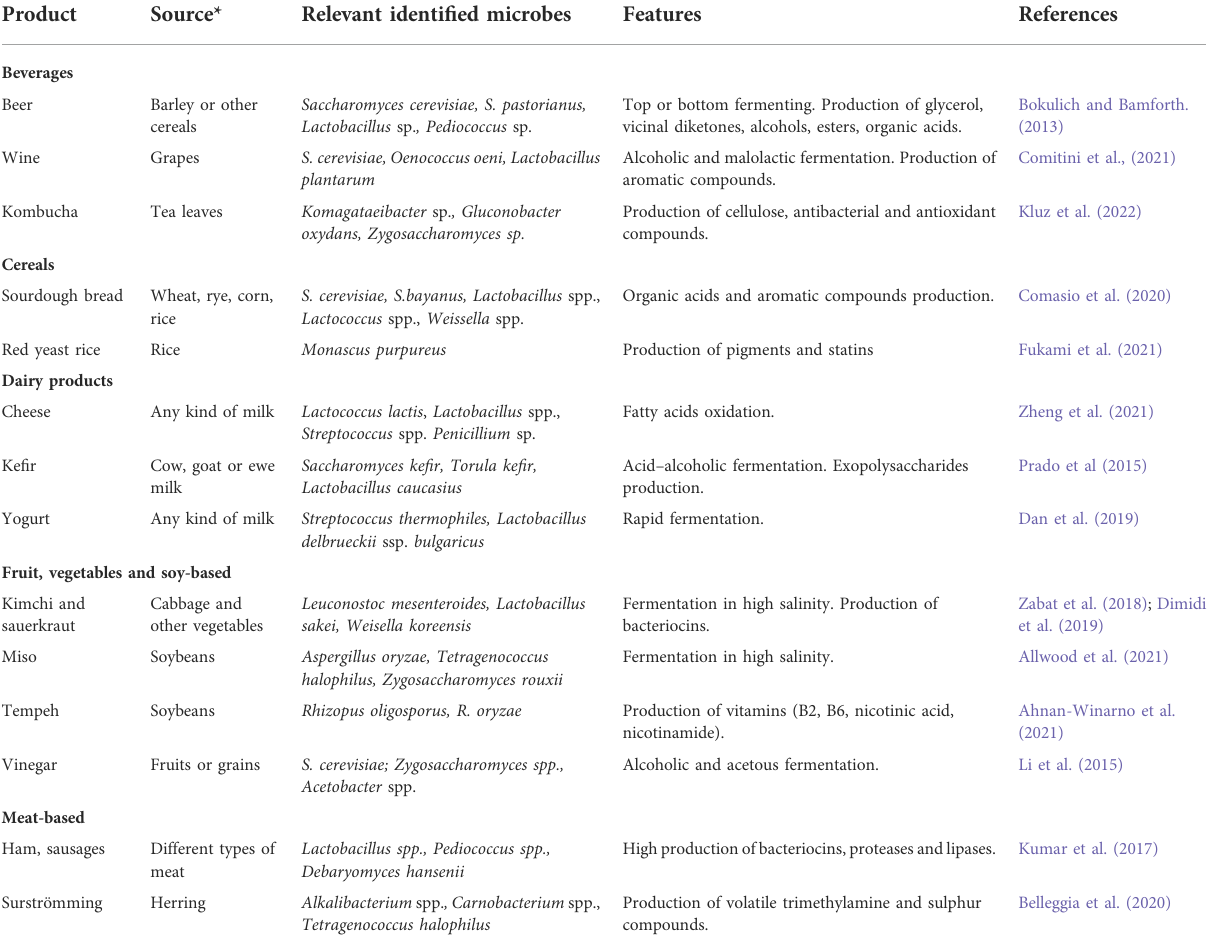
TABLE 1 Overview of some traditional fermentation procedures and their